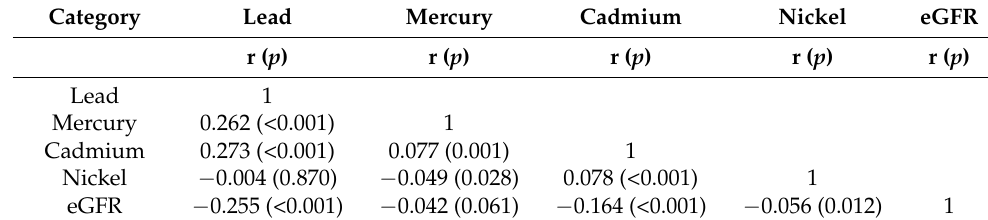
Table 4. Correlation between eGFR and blood lead, mercury, nickel, and cadmium.